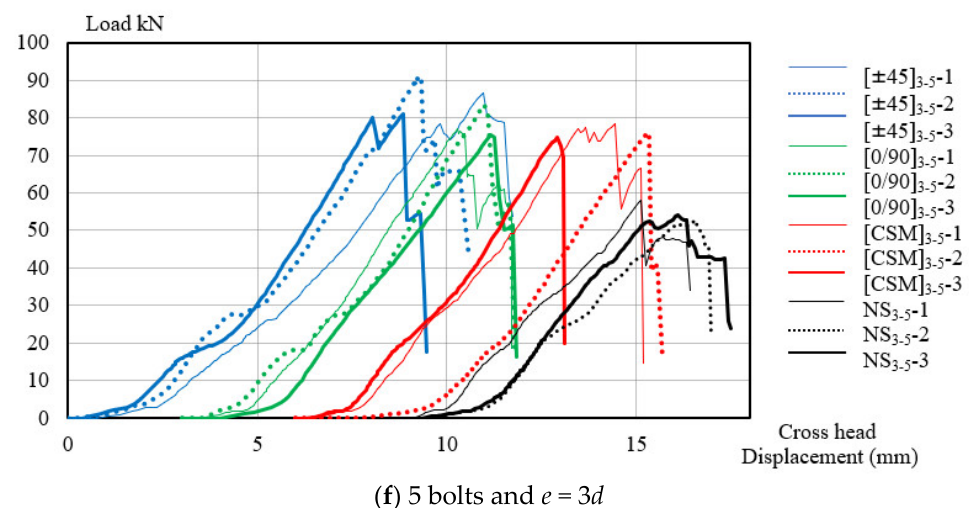
Figure 8. Load-cross head displacement relations in the PGFRP connections of all specimens: ( a ) 2 bolts and e = 2 d ; ( b ) 2 bolts and e = 3 d ; ( c ) 4 bolts and e = 2 d ; ( d ) 4 bolts and e = 3 d ; ( e ) 5 bolts and e = 2 d ; ( f ) 5 bolts and e = 3 d .